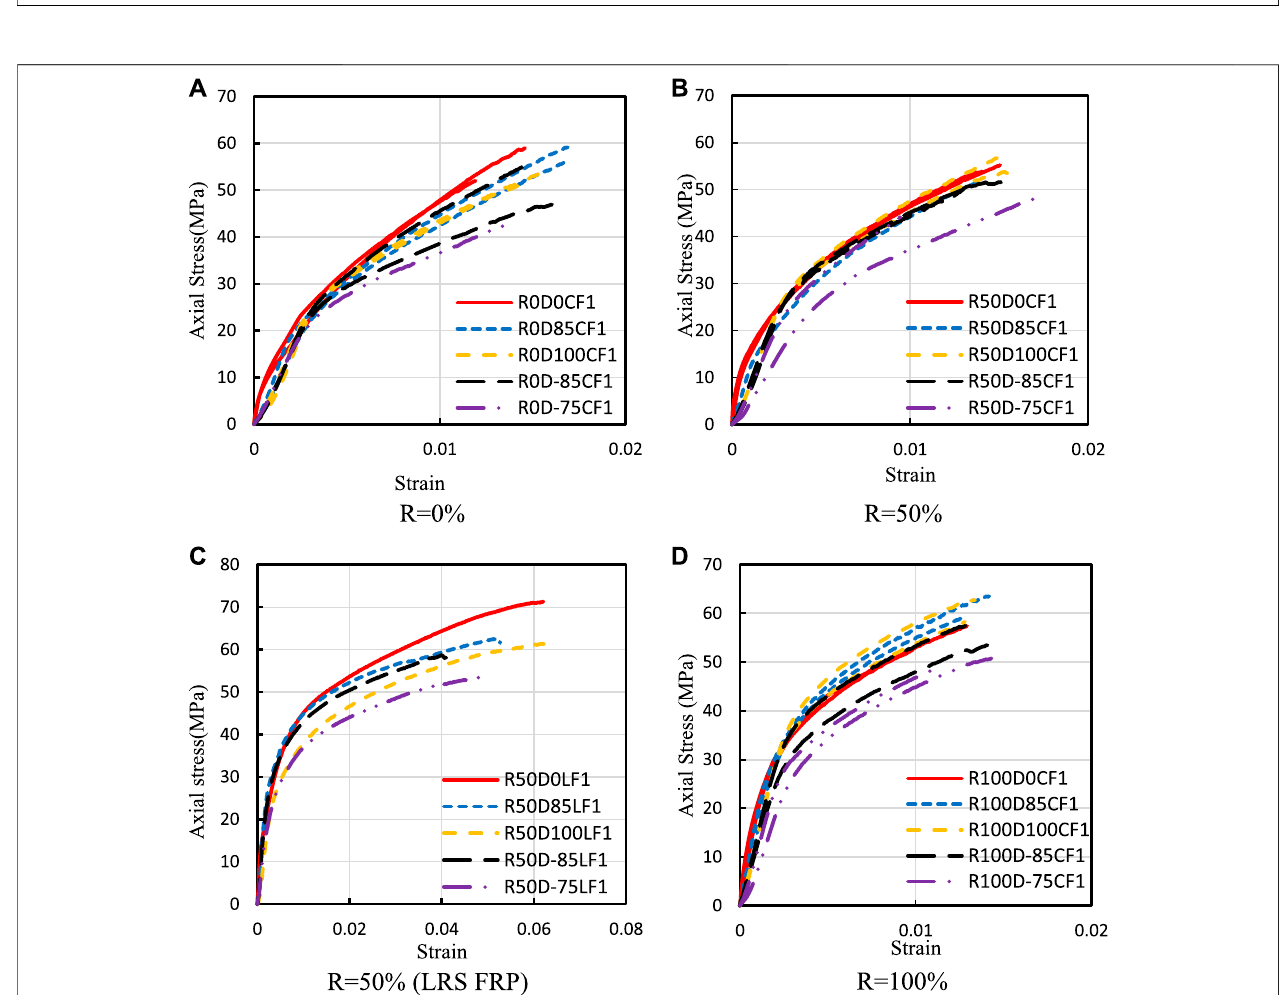
Figure 12 | Stress – strain curves with different pre-damage levels: (A) R (cid:2) 0%, (B) R (cid:2) 50%, (C) R (cid:2) 50% (LRS FRP), (D) R (cid:2) 100%.